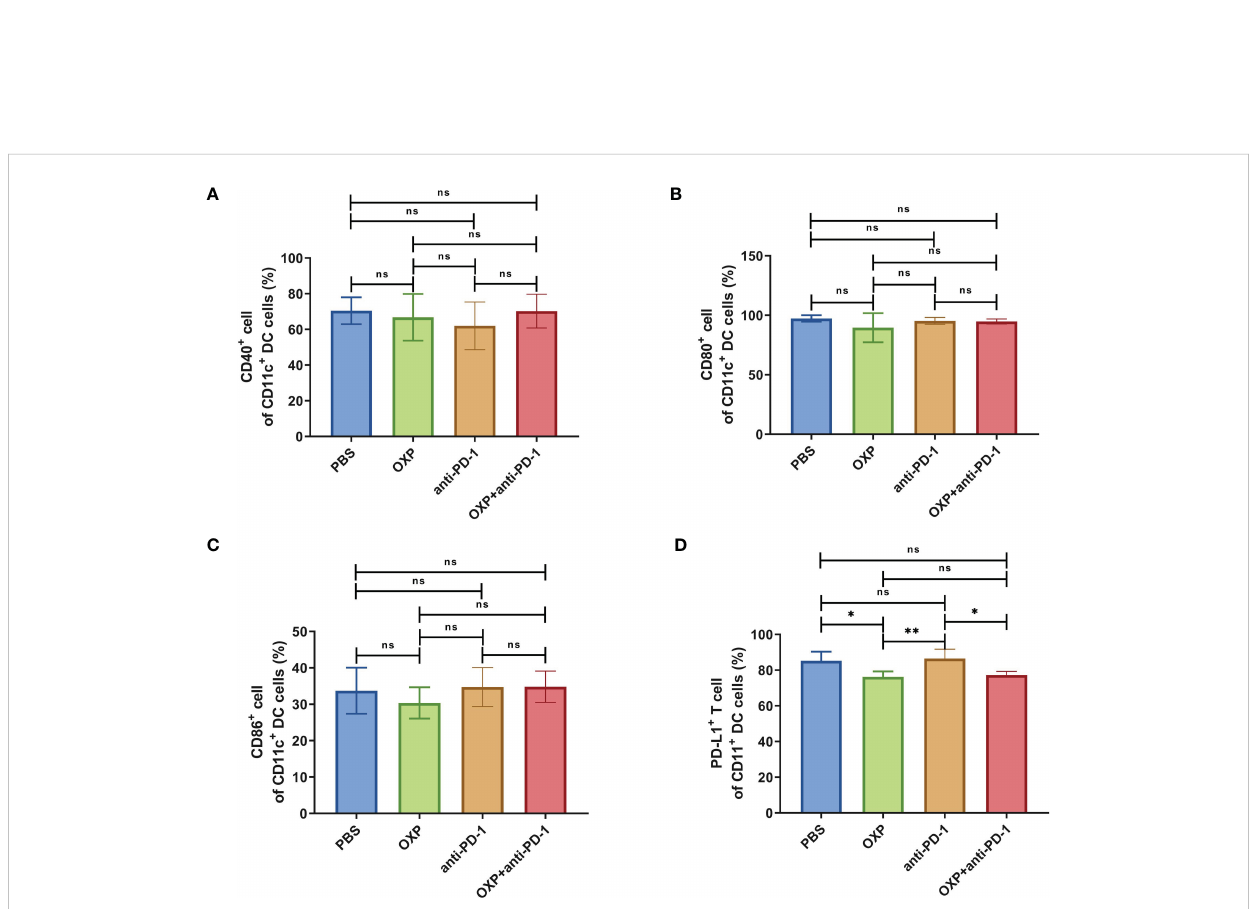
FIGURE 6 The phenotype of CD11c + DC cells in TIME. (A) The percentage of CD40 + cells of CD11c + DC cells. (B) The percentage of CD80 + cells of CD11c + DC cells. (C) The percentage of CD86 + cells of CD11c + DC cells. (D) The percentage of PD-L1 + cells of CD11c + DC cells. ns P > 0.05, *P < 0.05; **P < 0.01.